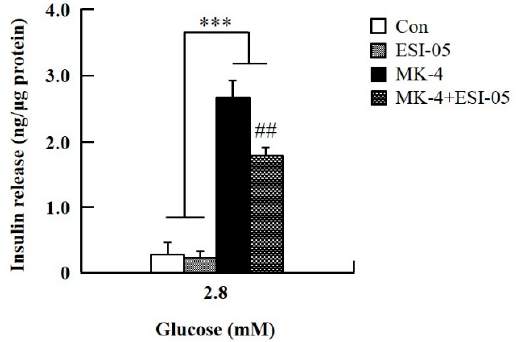
Figure 4. E ff ect of MK-4 on the activation of PKA in INS-1 cells. ( A ) E ff ects of MK-4 on luciferase activity in INS-1 cells. Cells were transfected with a CRE-inducible reporter gene and then treated with MK-4 for 3 h. ( B ) E ff ects of a PKA inhibitor (H89) on GSIS in INS-1 cells. Cells were treated with the indicated concentrations of glucose, MK-4 (3 µ M), and H89 (10 µ M) for 1 h. Insulin concentrations were measured by EIA. Data are presented as mean ± SD ( n = 3); *** p < 0.001.